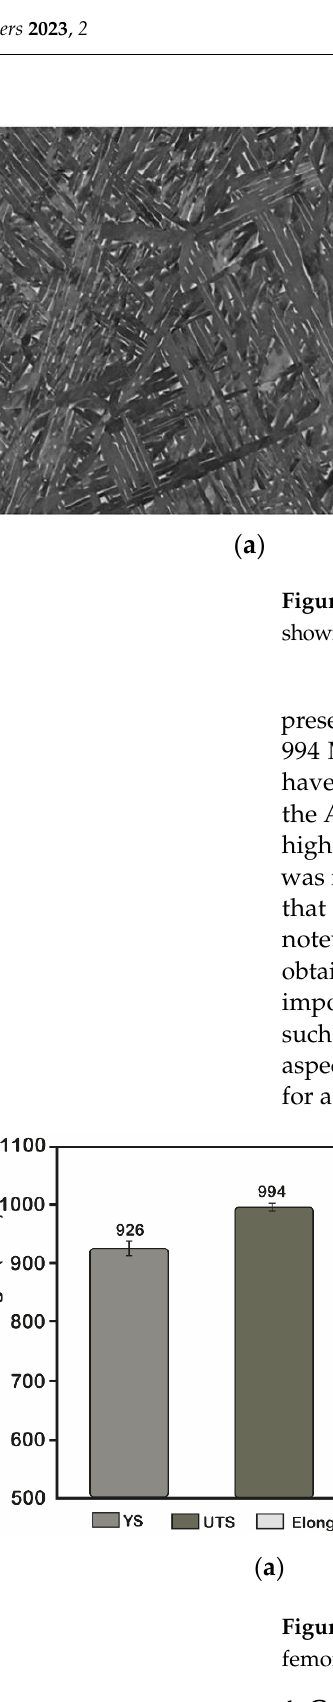
Figure 12. ( a ) Average YS, UTS and elongation to fracture of the DPF and heat-treated Ti-6Al-4V DPF femoral stem; ( b ) Representative stress–strain curve.